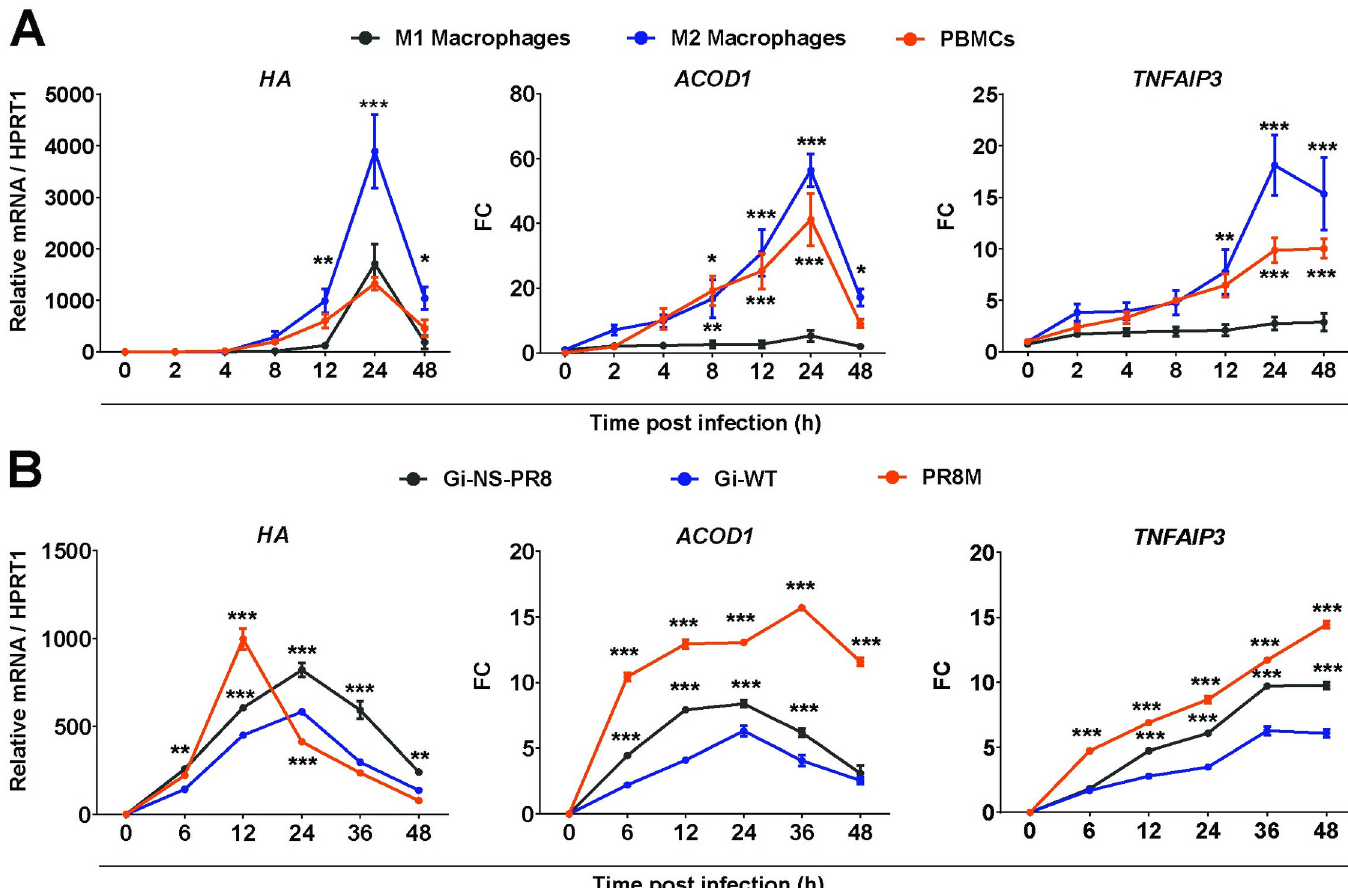
Fig 2. Differences among human myeloid cells in ACOD1 mRNA induction during IAV infection. Cells were infected with the indicated IAV strains (MOI = 1) and gene expression determined at the time points post infection (p.i.) indicated on the x-axes. A. Induction of ACOD1 and TNFAIP3 mRNA (RT-qPCR) in M1 and M2 macrophages and PBMCs during infection with IAV (PR8M). B. Induction of ACOD1 and TNFAIP3 (RT-qPCR) in dTHP-1 cells correlates with virulence of three IAV strains (Gi-WT = H1N1(pdm2009) field isolate; G-NS-PR8 = H1N1(pdm2009) reassortant carrying NS segment of PR8; PR8M = H1N1(PR8M). Reference for fold change = uninfected cells at the same point. Mean ± SEM (n = 4). HA = IAV hemagglutinin. � p < 0.05; �� p < 0.01; ��� p < 0.001 (two-way ANOVA, Tukey’s multiple comparisons test, with reference to M1 macrophages in A, and to Gi-WT in